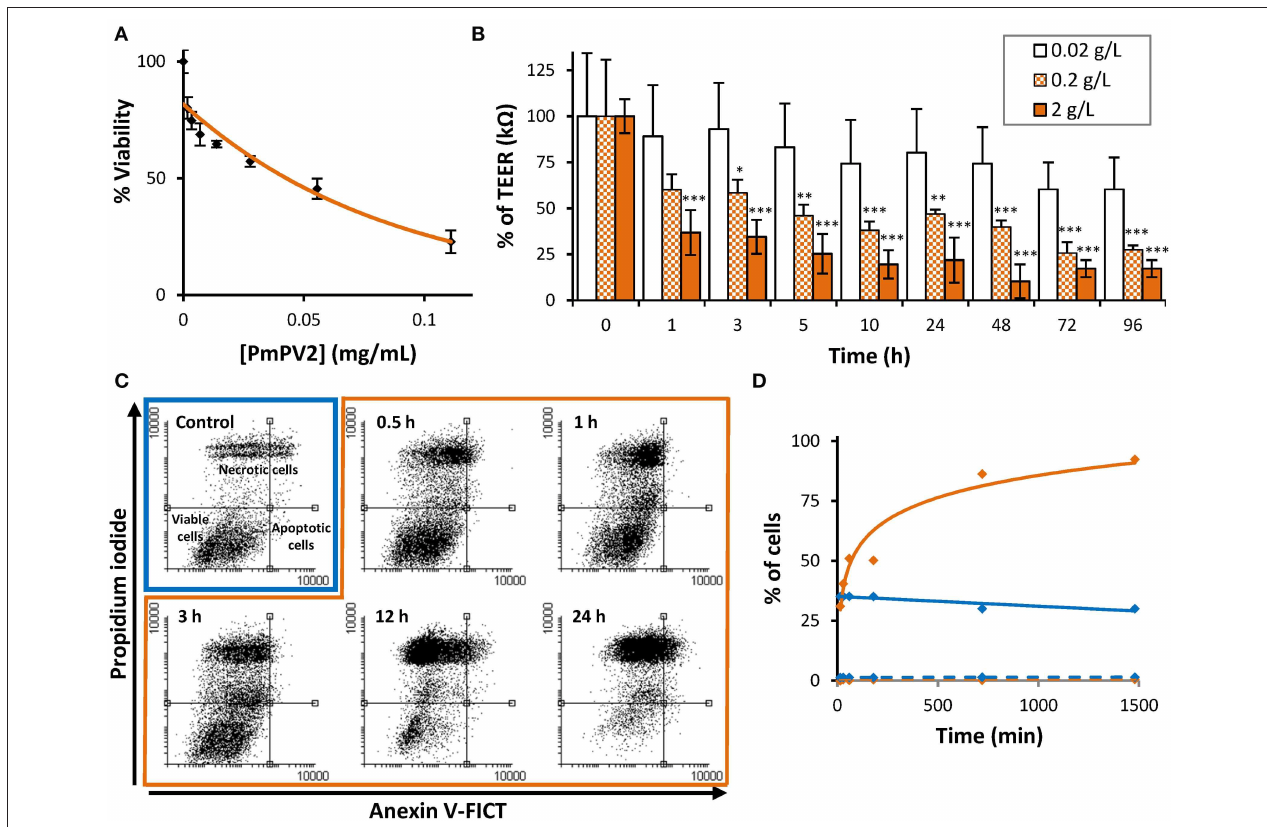
FIGURE 4 | PmPV2 is toxic to Caco-2 cells and disrupts enterocyte monolayers. (A) Cytotoxic effect of PmPV2 on Caco-2 cells evaluated using MTT assay. (B) Capacity of PmPV2 to disrupt a enterocyte monolayers (TEER assay) at three concentrations. Results are expressed as Mean ± SEM of three replicates. * P < 0.05, ** P < 0.01, *** P < 0.001. (C) Flow cytometry analysis showing type of cell death caused by PmPV2. Cells were doubly-labeled with anexin V-FICT/propidium iodide (PI), without (control, blue box) and with 0.05 mg/mL PmPV2 (orange box) at 0.5, 1, 3, 12 and 24h. Viable cells: FICT − /PI − ; Apoptotic cells: FICT + /PI − ; Necrotic cells: FICT − /PI + and FICT + /PI + . (D) percentage of apoptotic (dashed line) and necrotic (full line) cells obtained in (C) . Blue lines: control; orange lines: treated with